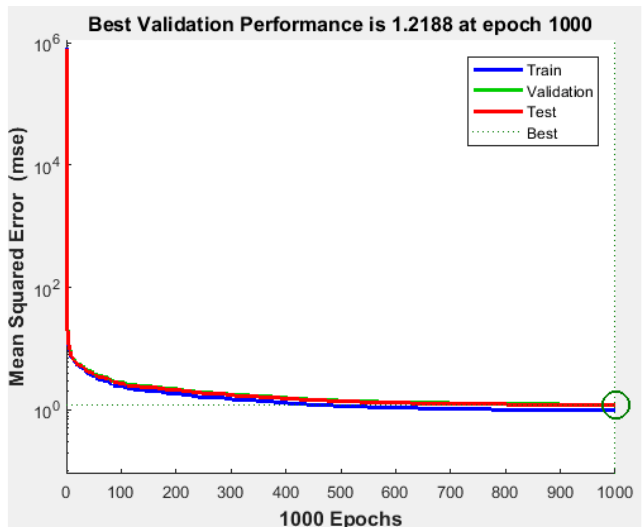
Figure 5. Performance of the training, validation, and testing data with the LM algorithm at 1000 neurons in the hidden layer.